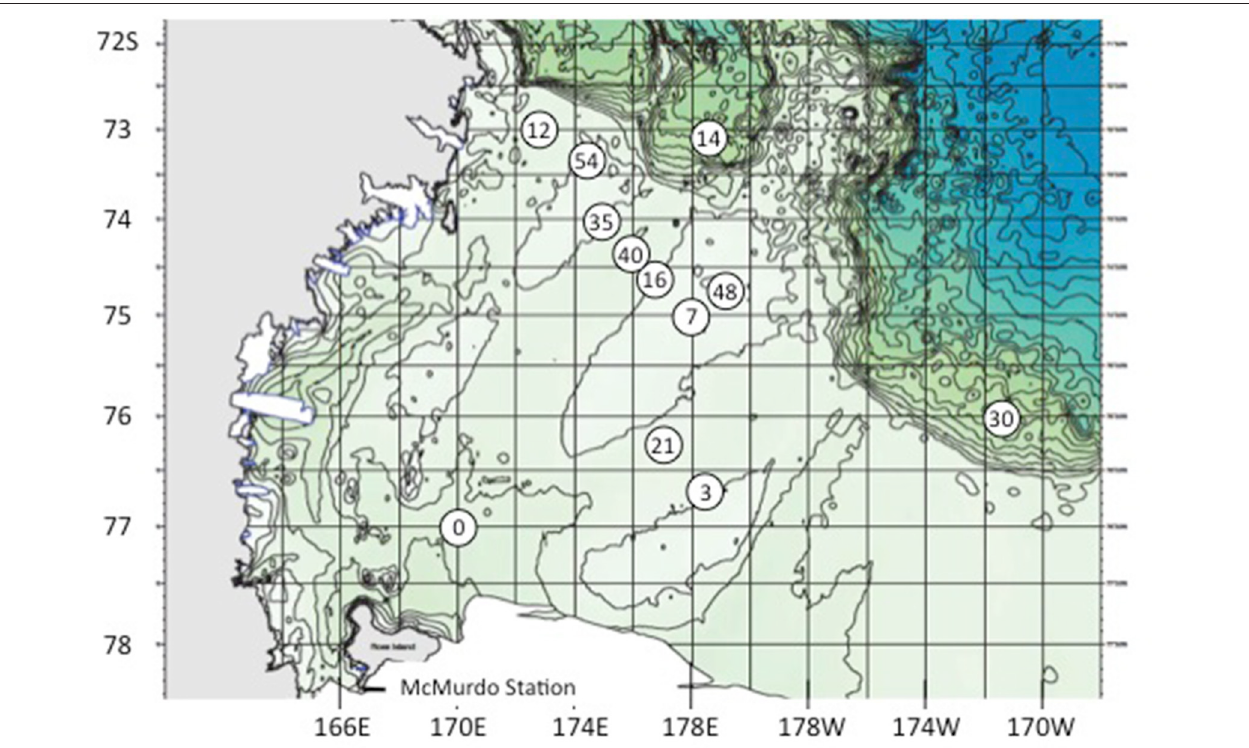
FIGURE 1 | Stations sampled in the Ross Sea, Antarctica, Jan/Feb 2011. BrdU experiments were accomplished at stations 14, 21, 30, and 54. Station 7 is also 61, and 16 is also